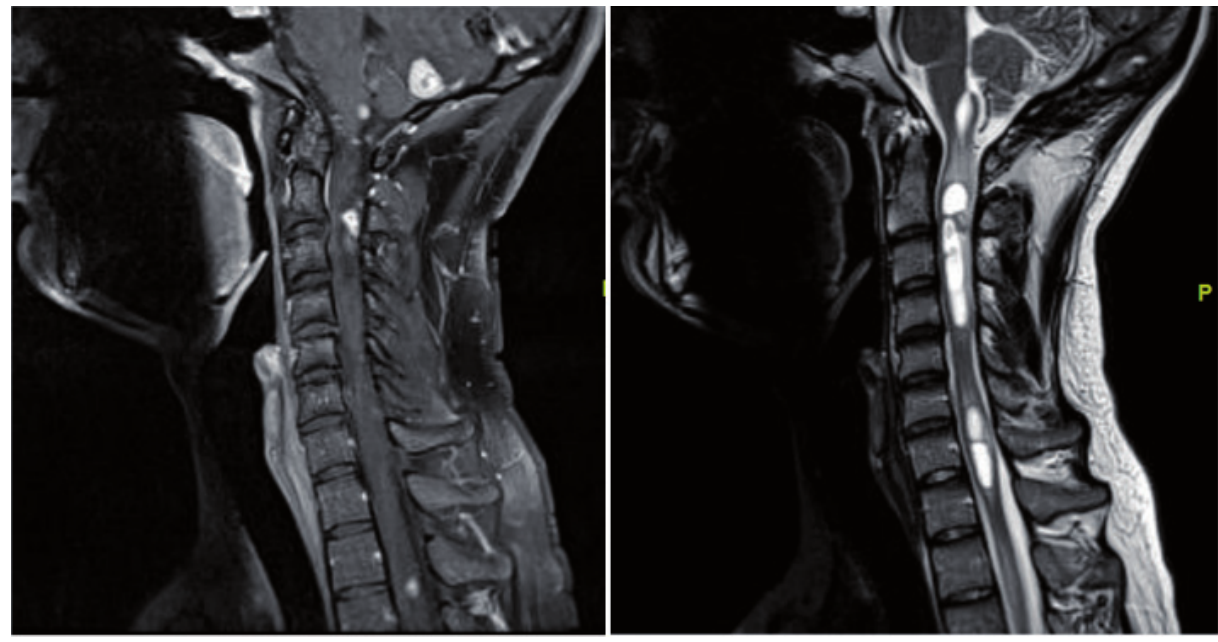
Figure 1. Sagittal MRI of posterior fossa and cervical spine. Left : T1 with gadolinium shows multiple enhancing HB tumors involving cerebellum, brainstem, and spinal cord. Right : T2 MRI shows multiple intramedullary cystic lesions consistent with VHL